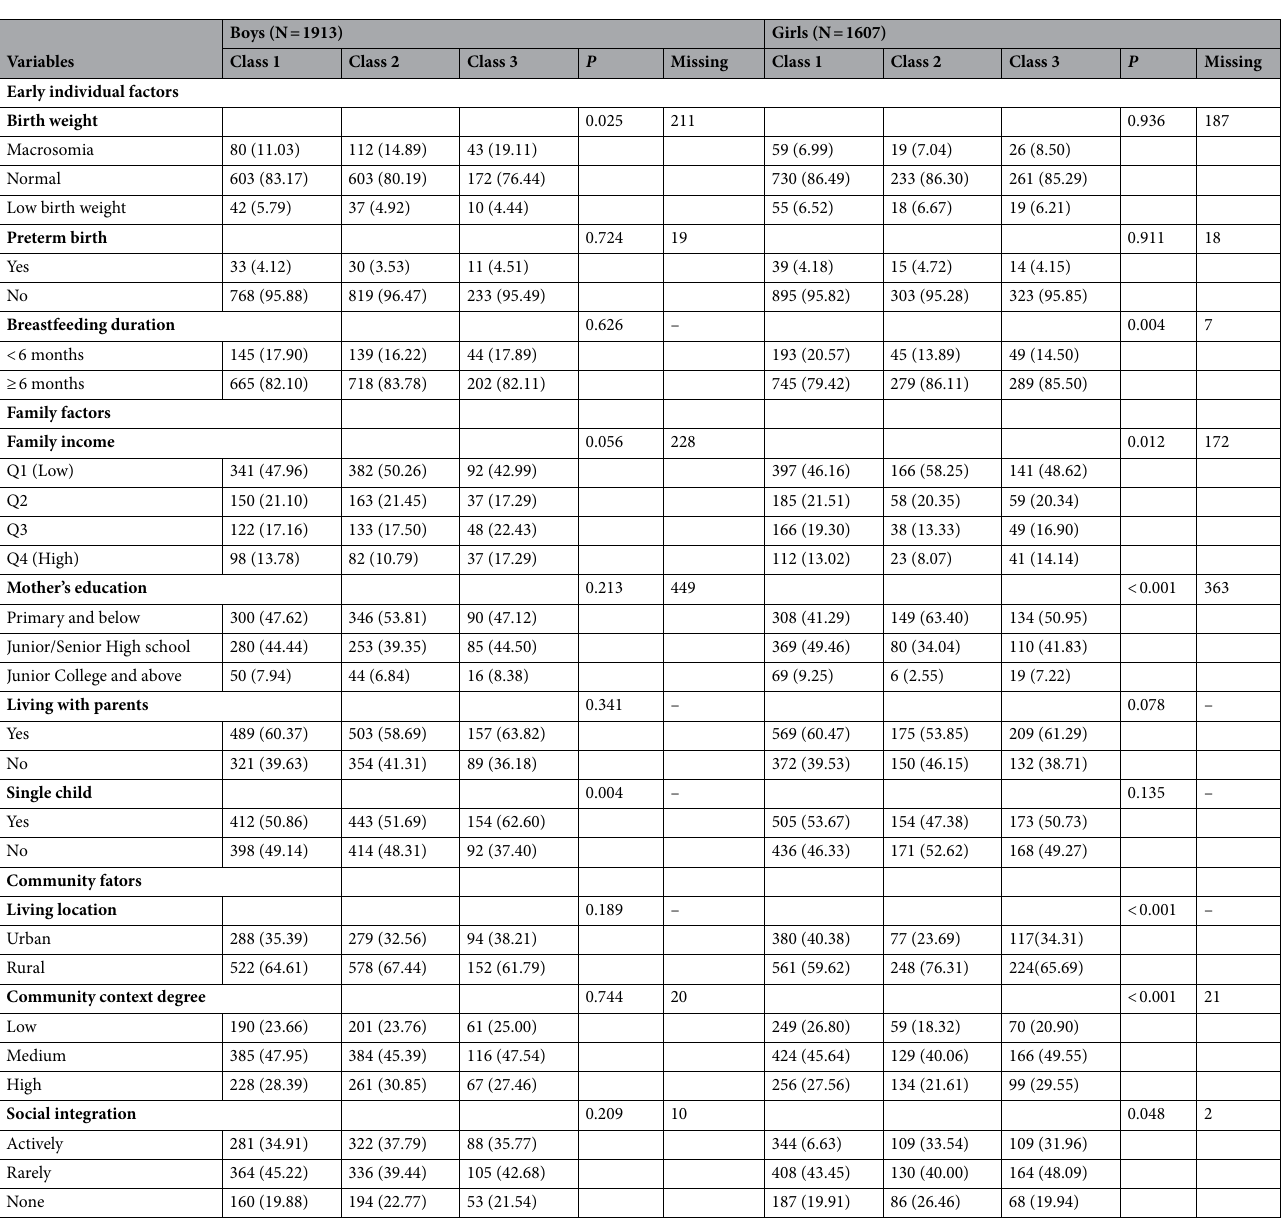
Table 4. Baseline characteristics of the population-based sample and analysis sample, CFPS. Number and percentage (N, %) are